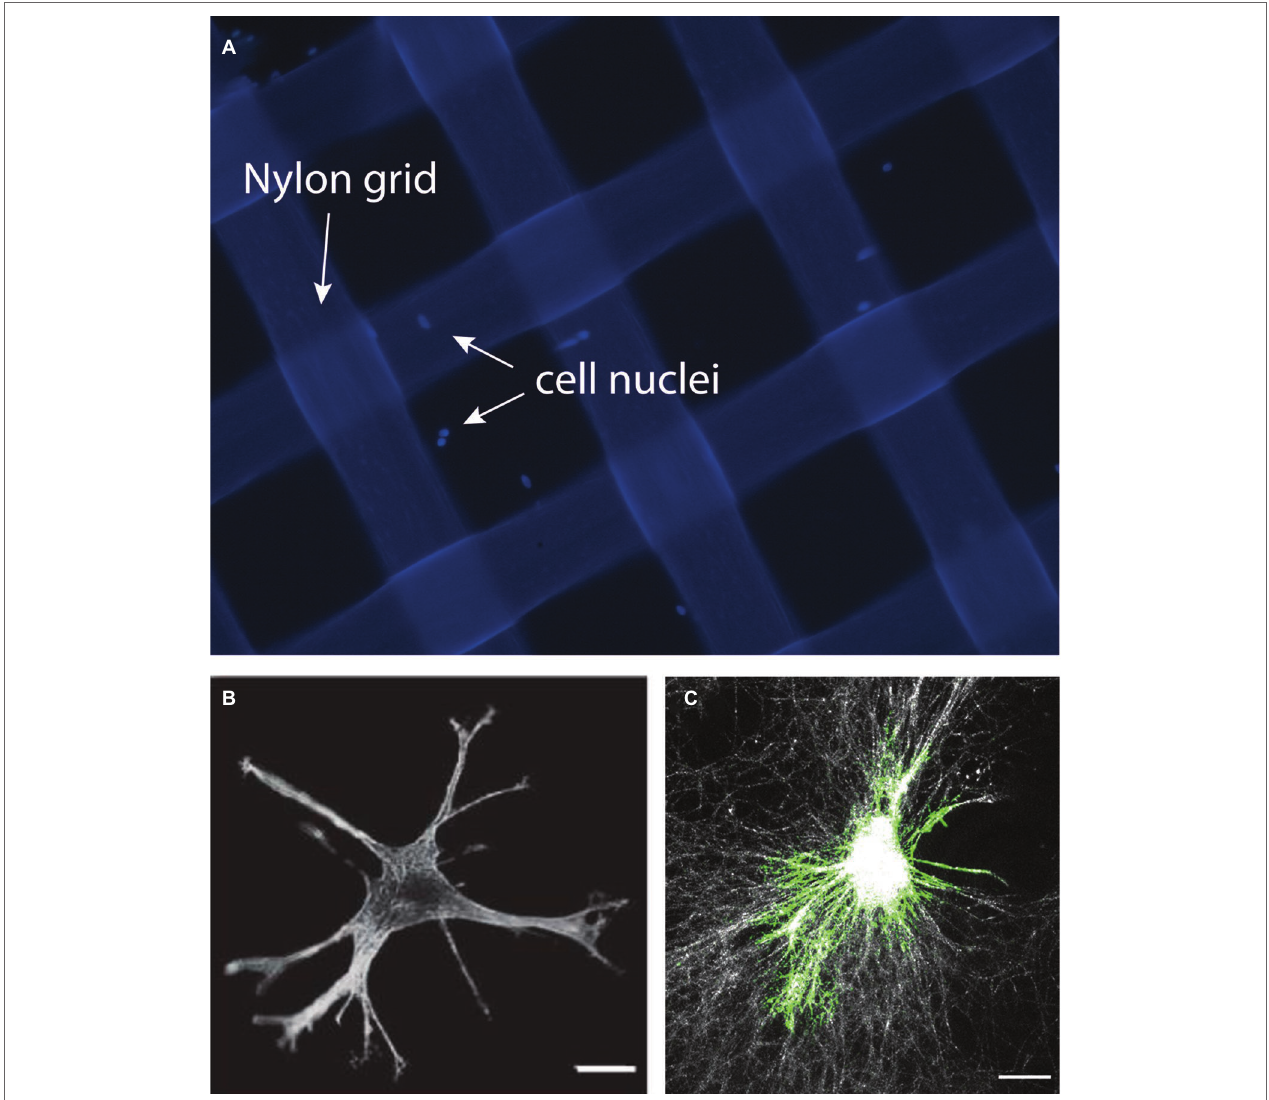
FIGURE 5 | In this model, collagen-coated nylon grids of varying widths are created to assess the impact of lateral boundary sensing by periodontal fibroblasts. A collagen gel is prepared using the nylon grids. Image shows nylon grids (200 × 200 μ m) treated with collagen. Cells were stained with DAPI to reveal the cell